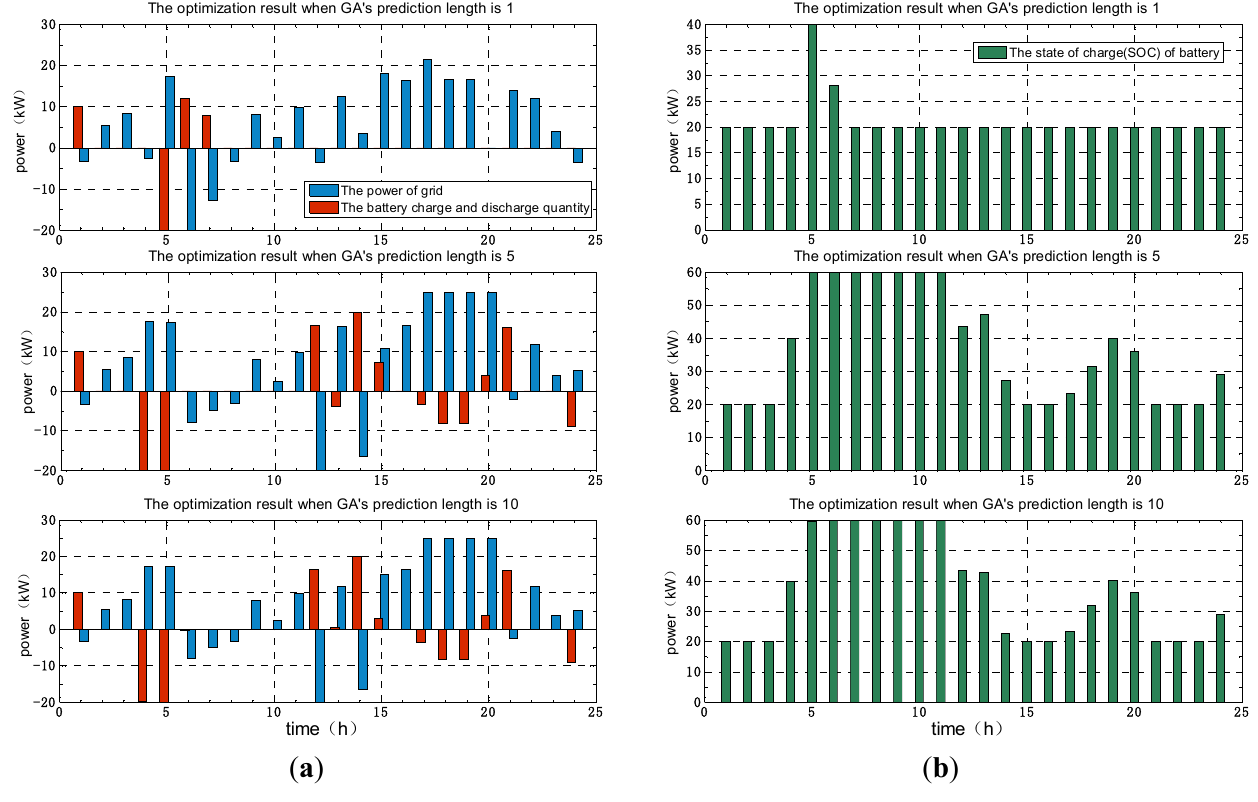
Figure 13. The optimization result of a GA for different prediction lengths: ( a ) The optimization result of the external grid and battery power; ( b ) The optimization result of the battery’s SOC capacity.